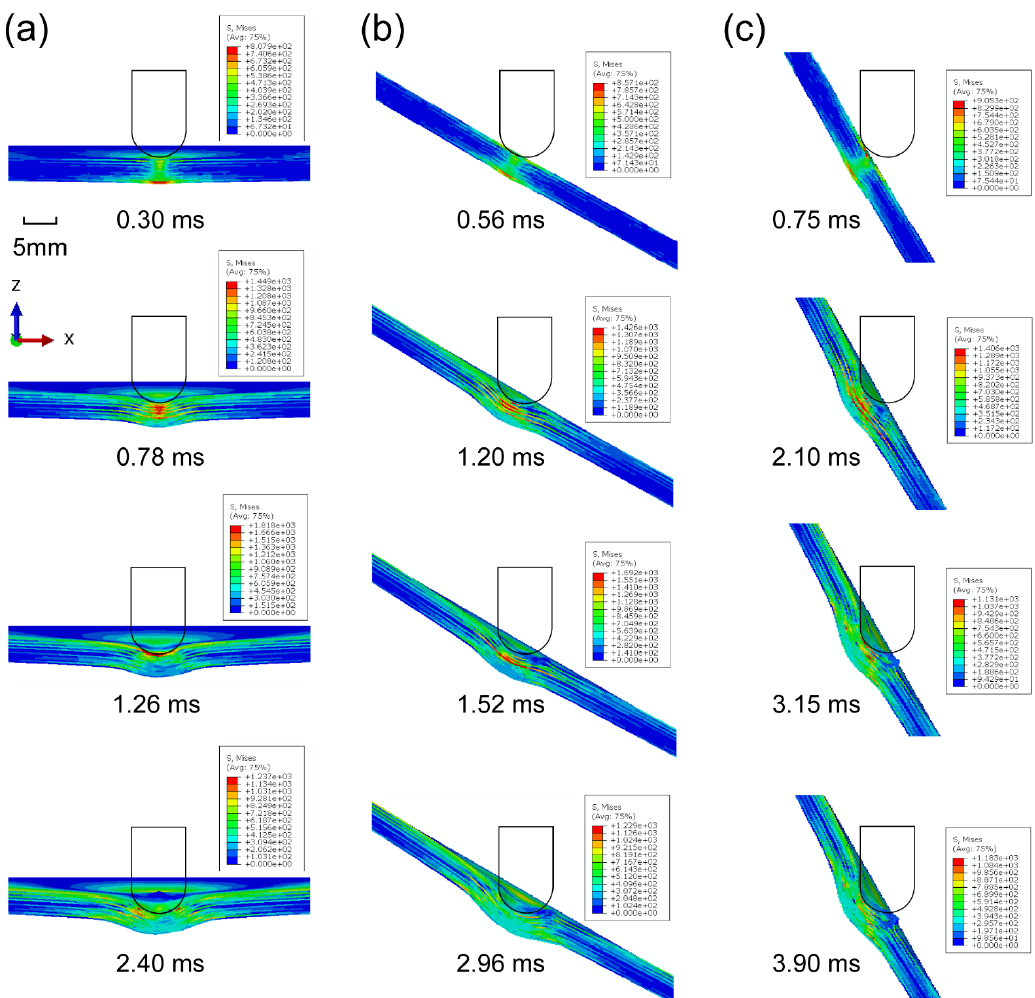
Figure 3. Progressive deformation and stress distribution of laminates with ( a ) 0°, ( b ) 30°, and ( c ) 60° impact angles under 20 J impact energy.